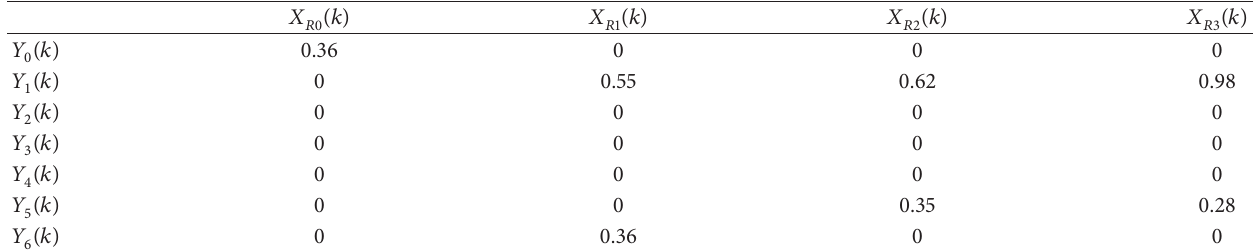
of the sensitivity of reactive stimuli. YM